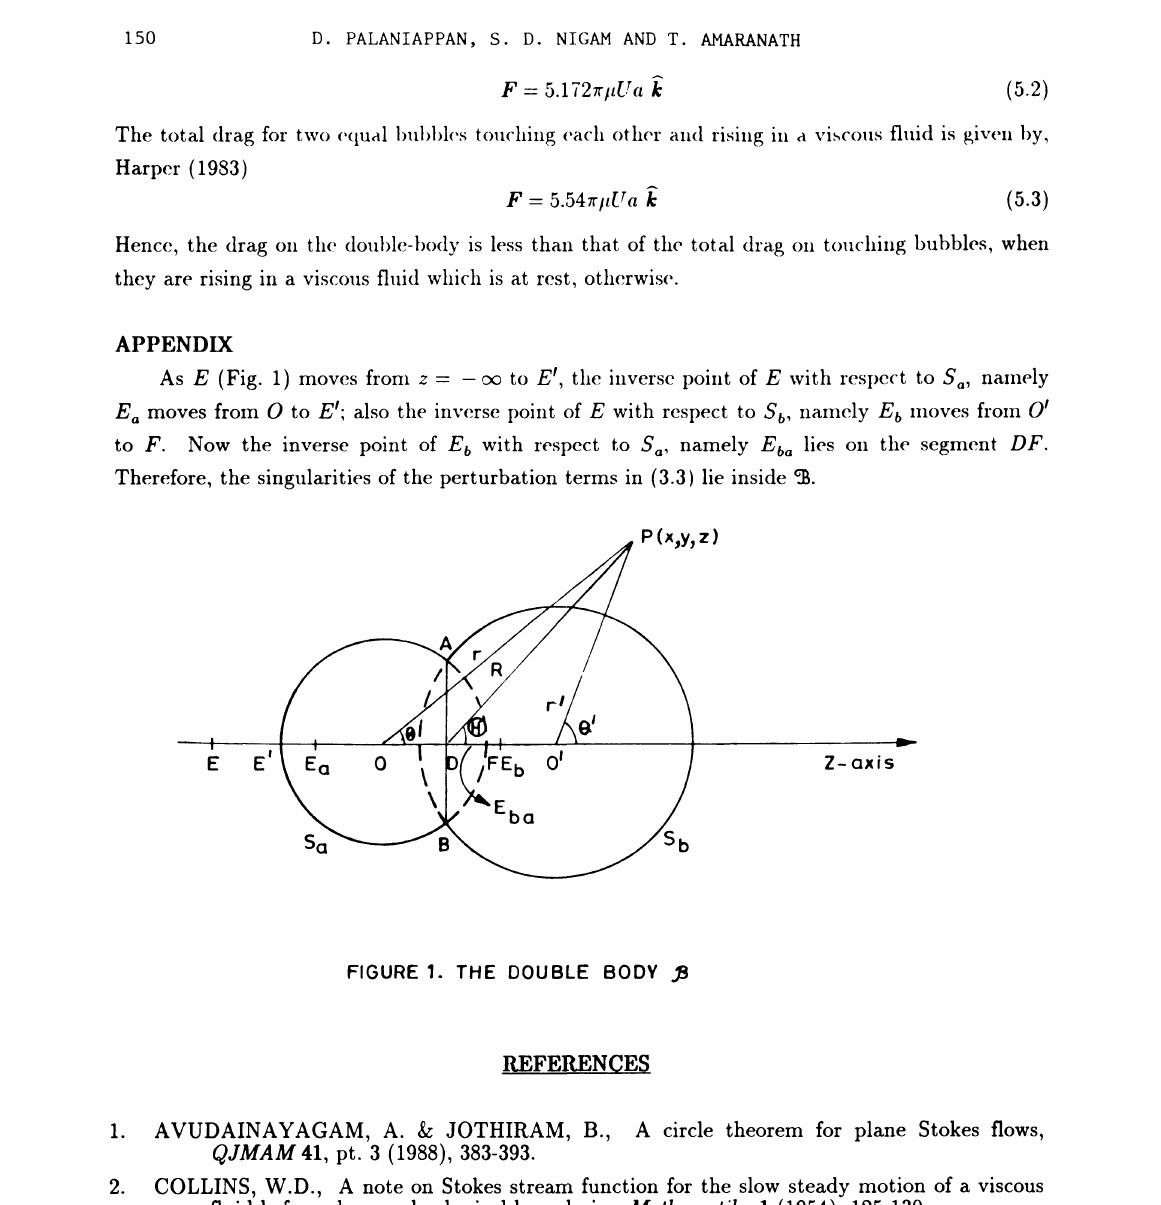
FIGURE 1. THE DOUBLE